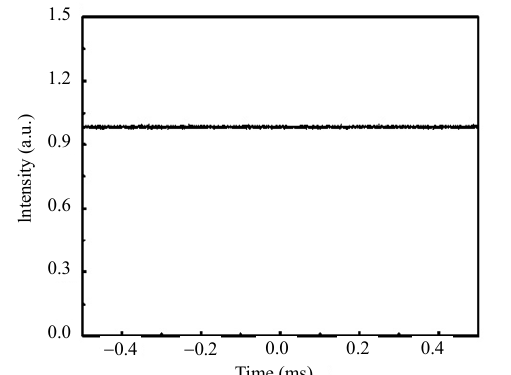
Fig. 6 Normalized temporal dynamics of the laser at the maximum output